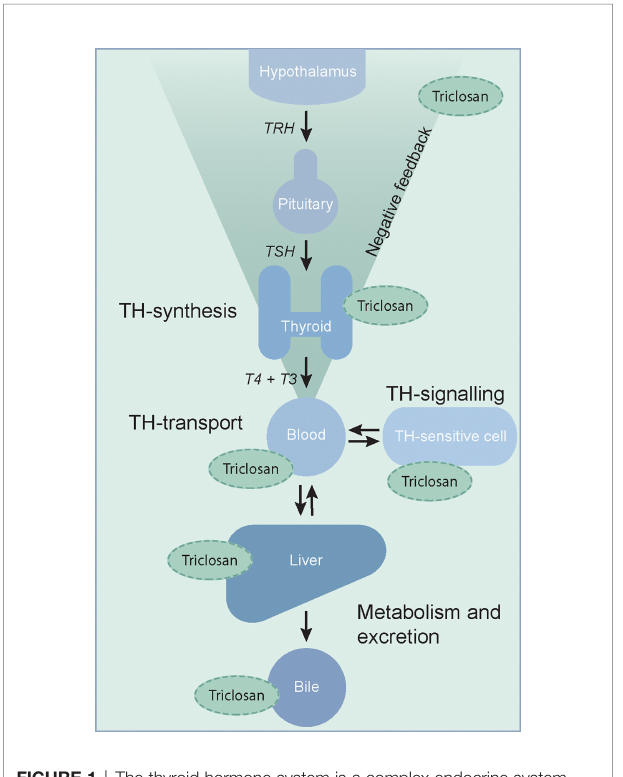
FIGURE 1 | The thyroid hormone system is a complex endocrine system with many potential targets of thyroid hormone system disrupting chemicals. Putative sites of interference by triclosan, as discussed in this review, are indicated. TH, thyroid hormone; T4, thyroxine; T3, 3,3´,5-tri-iodothyronine; TSH, thyroid stimulating hormone; TRH, thyrotropin releasing hormone.